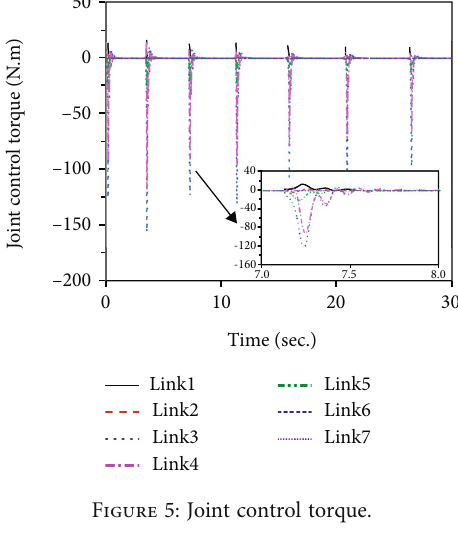
Figure 5: Joint control torque.